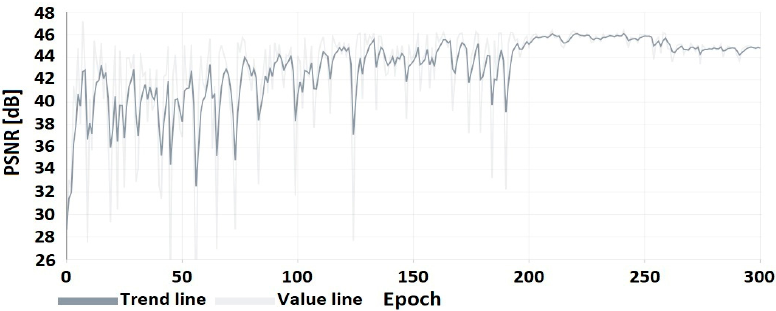
Figure 5. PSNR of the coder image (trained on CRF = 24) to the image after HEVC compression.